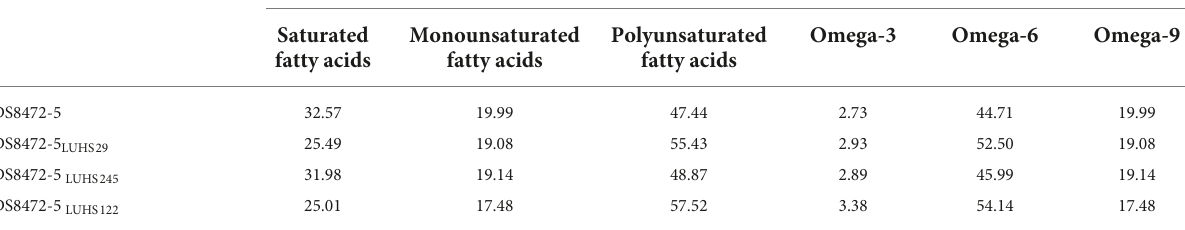
TABLE 3 Fatty acid (FA) profiles of wheat cereal wholemeal (WCW) (DS8472-5) samples. Wheat wholemeal samples Fatty acid concentration, % from total fat content Saturated fatty